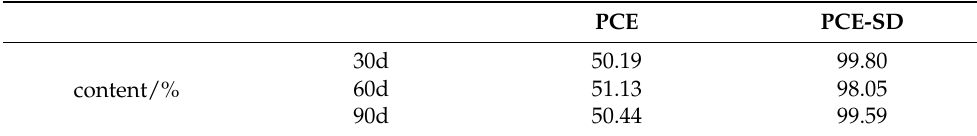
Table 8. The content of PCE and PCE-SD uinlong-term retention